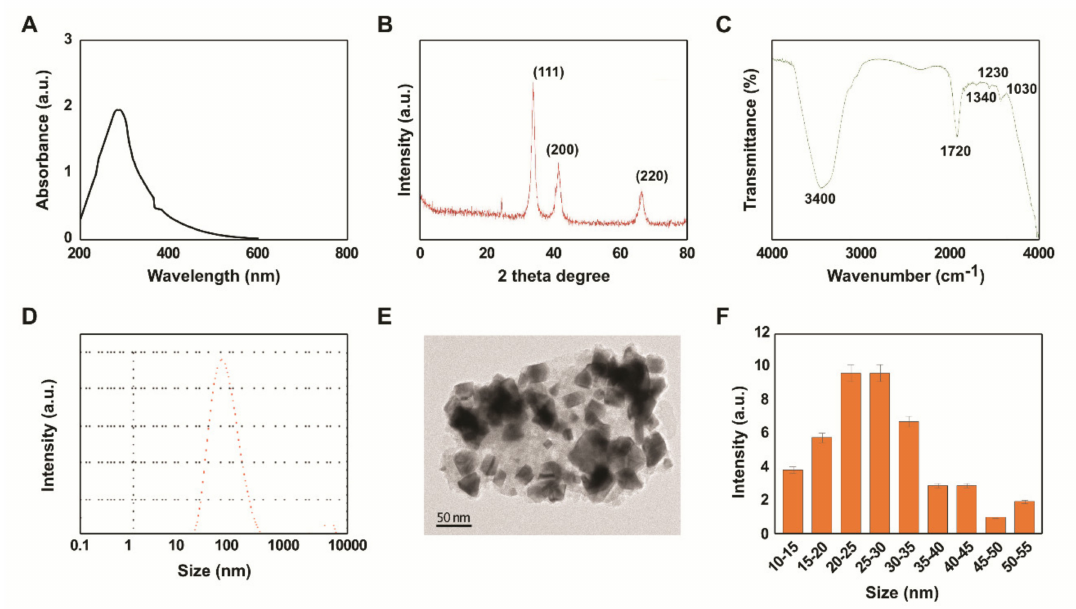
Figure 1. Synthesis and characterization of platinum nanoparticles (PtNPs) using β -carotene. Absorption spectra of beta carotene-mediated synthesis of PtNPs ( A ). X-ray di ff raction patterns of PtNPs ( B ). FTIR spectra of PtNPs ( C ). Size distribution analysis of PtNPs using DLS ( D ). TEM images of PtNPs ( E ). Histograms showing particle size distribution ( F ). At least three independent experiments were performed for each sample and reproducible results were obtained. The data represent the results of a representative experiment. PtNPs, platinum nanoparticles; FTIR, Fourier-transform infrared; DLS, dynamic light scattering; TEM, transmission electron